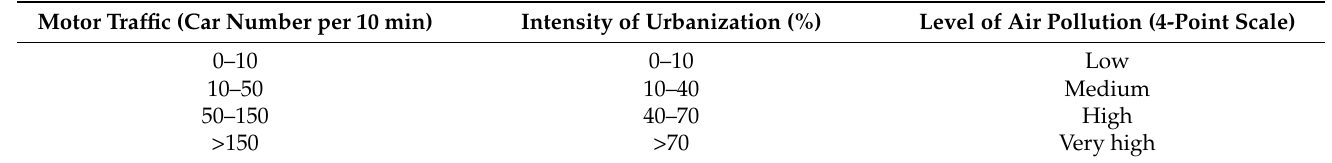
Figure 1. Map of the city of Plovdiv (Bulgaria) and locations of the four selected plots (1—Plot 1; 2—Plot 2; 3—Plot 3; 4—Plot 4). Table 1. Level of air pollution evaluated on the basis of car traffic and intensity of urbanization.